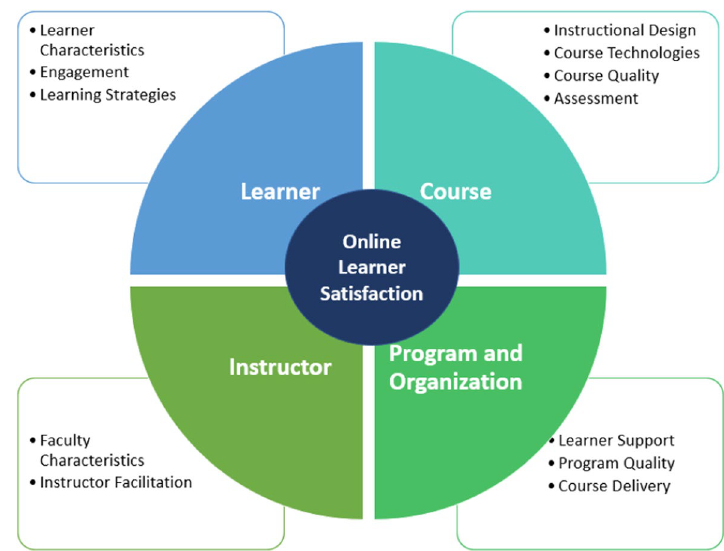
Fig. 3 Online Learner Satisfaction (OLS)